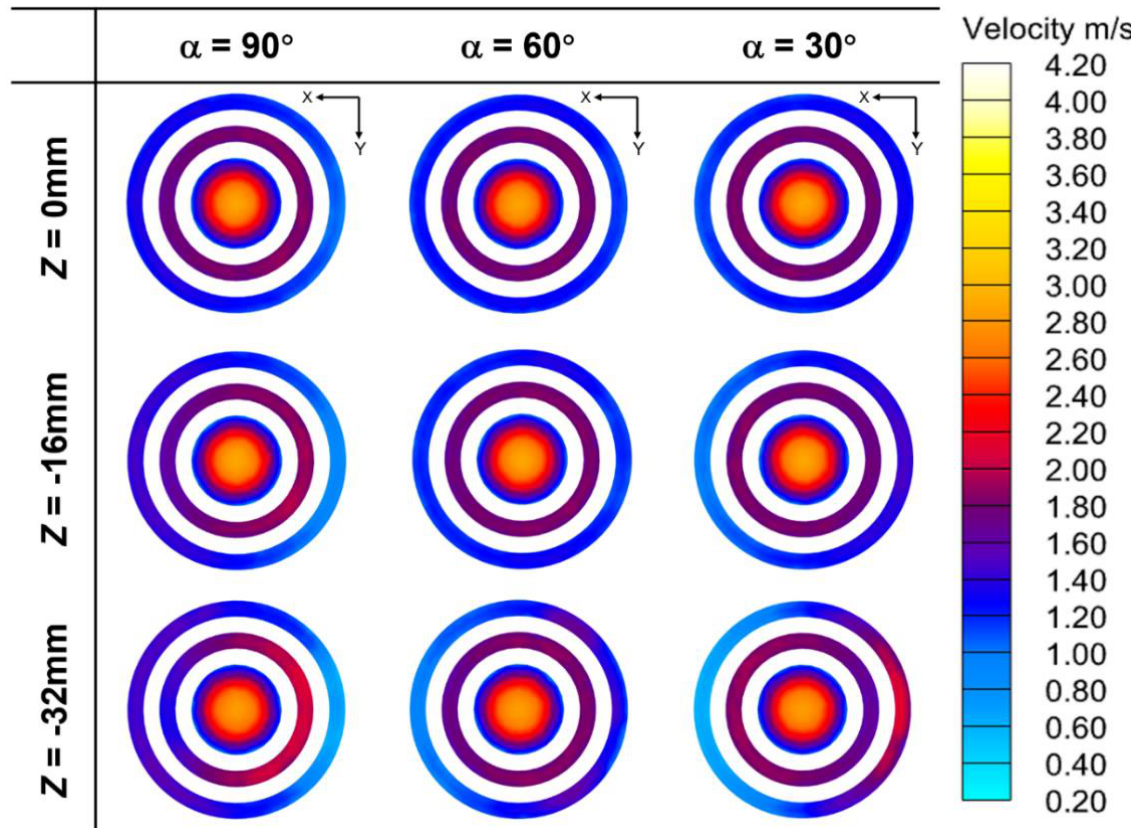
Figure 3. Velocity contour on the sampling plane of the powder conveying pipe group.